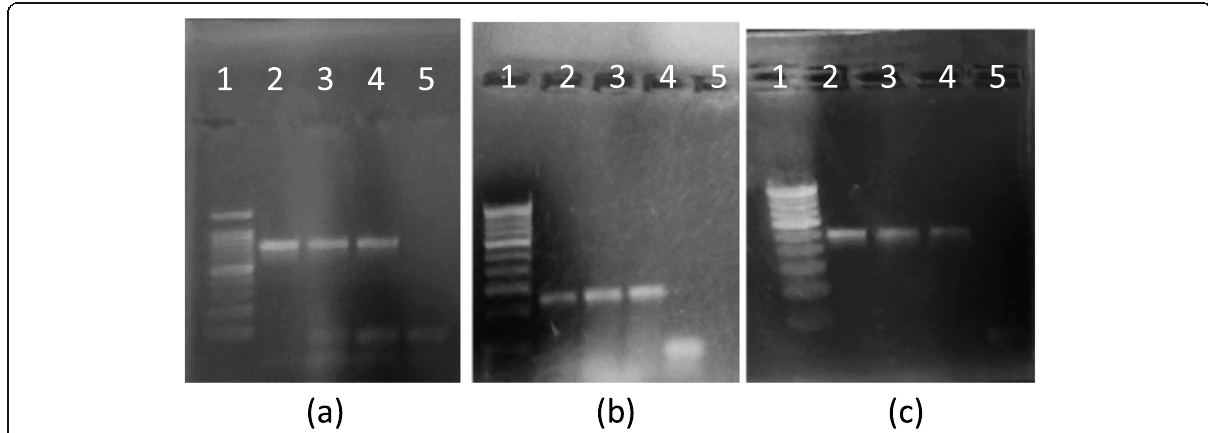
Fig. 5 PCR master mix volume variation. a 16s r-DNA: lane 1 — 100 bp ladder, lane 2 — colony PCR, lane 3 — 25 μ L master mix volume, lane 4 — 50 μ L master mix volume, lane 5 — negative control. b β -galactocidase lane 1 — 100 bp ladder, lane 2 — colony PCR, lane 3 — 25 μ L master mix volume, lane 4 — 50 μ L master mix volume, lane 5 — negative control. c ITS: lane 1 — 100 bp ladder, lane 2 — colony PCR, lane 3 — 25 μ L master